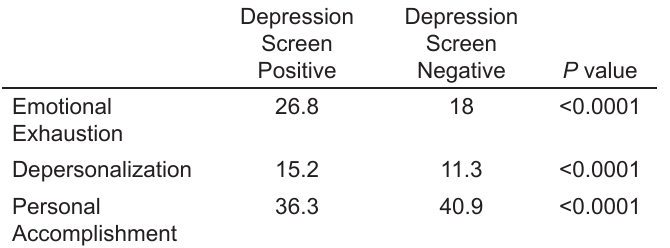
Table 3. Mean burnout scores and depression screen results.